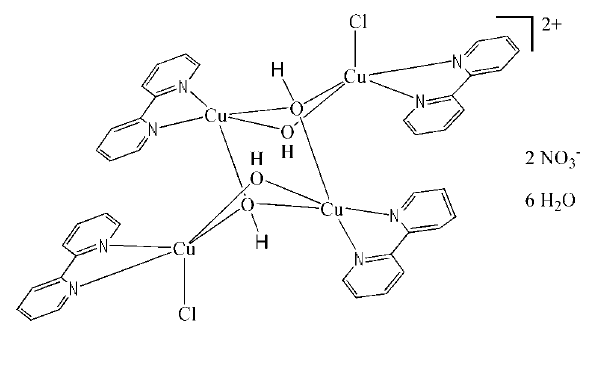
centroid–centroid separations of 3.724 (2) and 3.767 (3) A˚ . Related literature